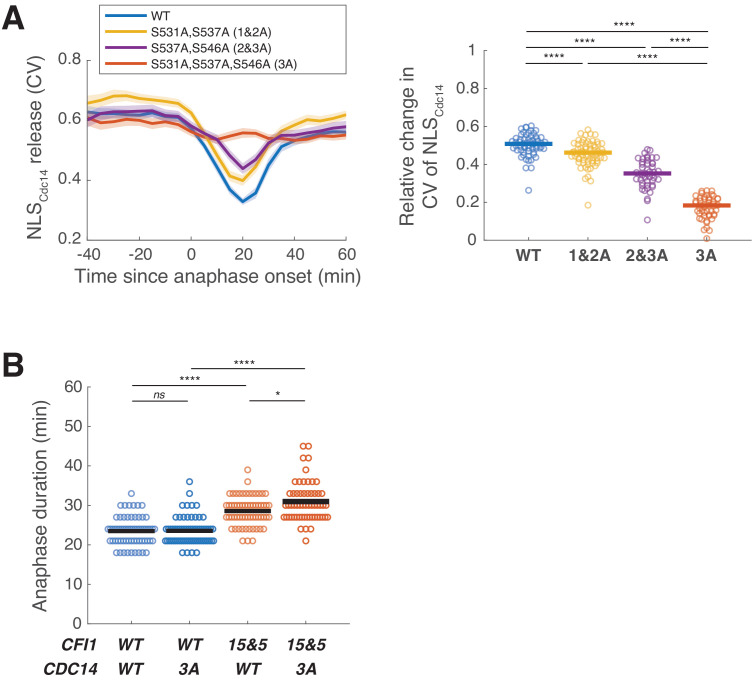
Phosphorylation of the Cdc14 nuclear localization signal (NLS) does not play a major role in promoting mitotic exit.(A) Profiles (left) and relative degrees (right) of nuclear release of wild-type (A41584, n = 69 cells) and mutant NLSCdc14 reporters where all three potential Dbf2-Mob1 target sites (A41585, n = 59 cells) or only two out of three sites (A41586 and A41623, n = 77 and 55 cells) were mutated to alanine. Cells were grown at 25°C in SC medium + 2% glucose and imaged every 5 min for 4 hr. Solid lines (right) represent the median. (B) Distribution of anaphase duration for CDC14 phospho-mutants in combination with CFI1 or cfi1-Cdc15&Cdc5(z2) measured using the spindle pole body (SPB) marker Spc42-eGFP (A41436, A41707, A41592, and A41708; n = 64, 65, 61, and 58 cells, respectively). Cells were grown at 25°C in SC medium + 2% glucose and imaged every 3 min for 4 hr. Anaphase duration was defined as the time from anaphase onset (spindle length >3 μm) to mitotic exit (spindle breakdown). Solid lines represent the mean. ****p<0.0001; *p<0.05; ns, not significant (p>0.05) by two-sided Wilcoxon rank sum test.